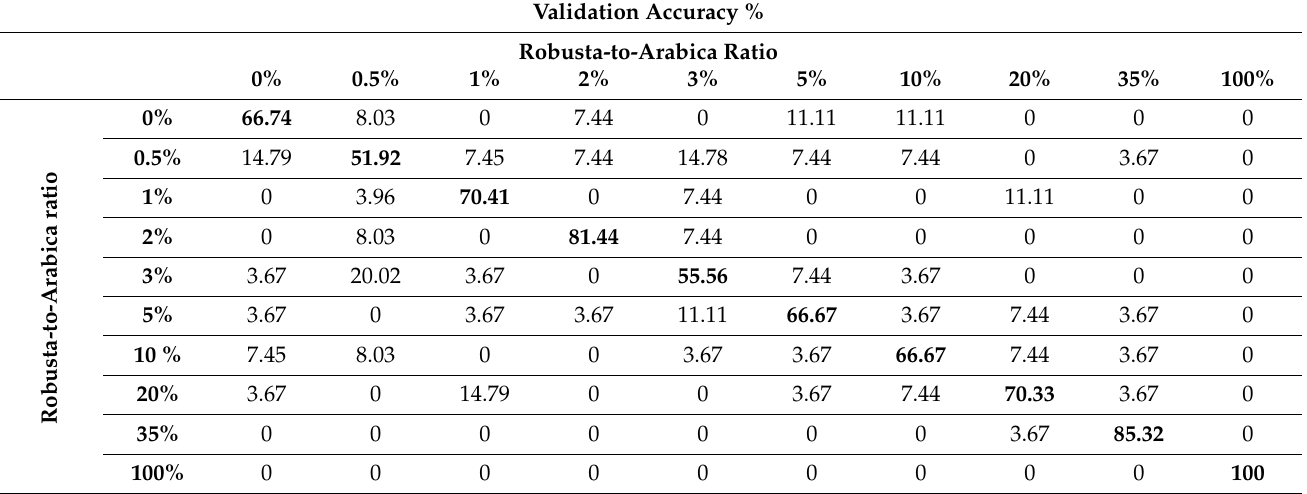
Table 1. PCA-LDA classification model on the NIRS data of pure and adulterated mixtures after three-fold cross-validation (N =